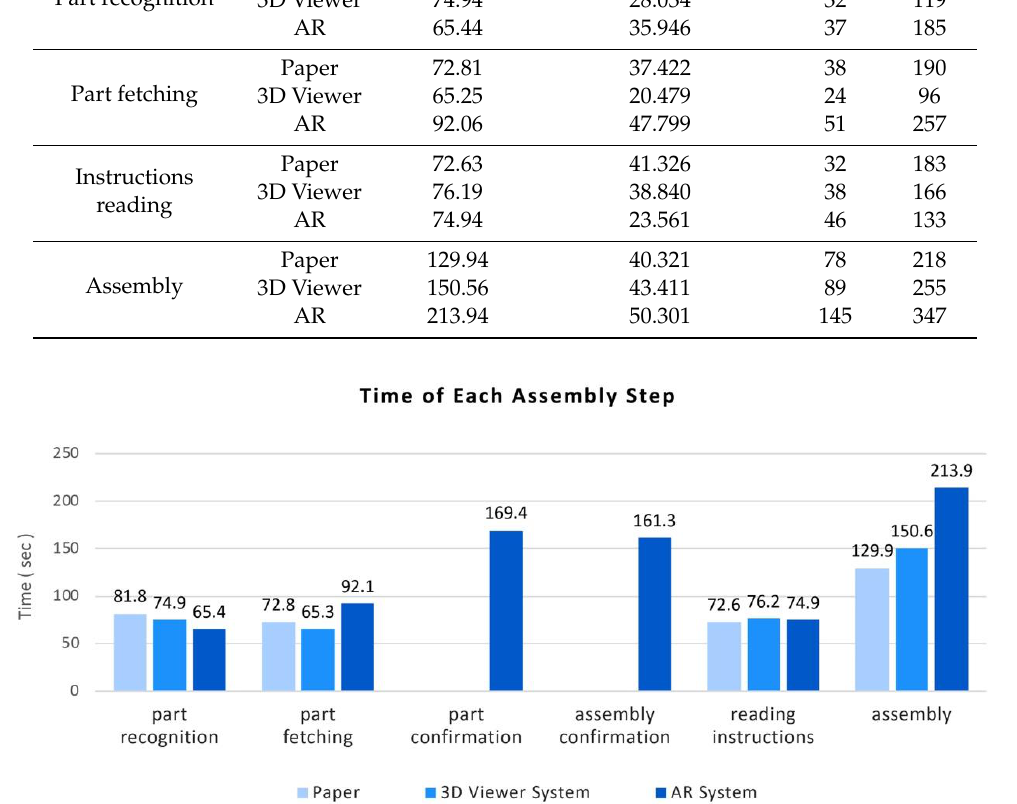
Figure 12. Time of each assembly step for the paper, 3D viewer, and AR assistance.